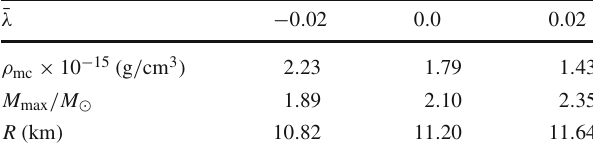
Table 5 The maximum mass and the corresponding radius for three- form field quark stars with constant